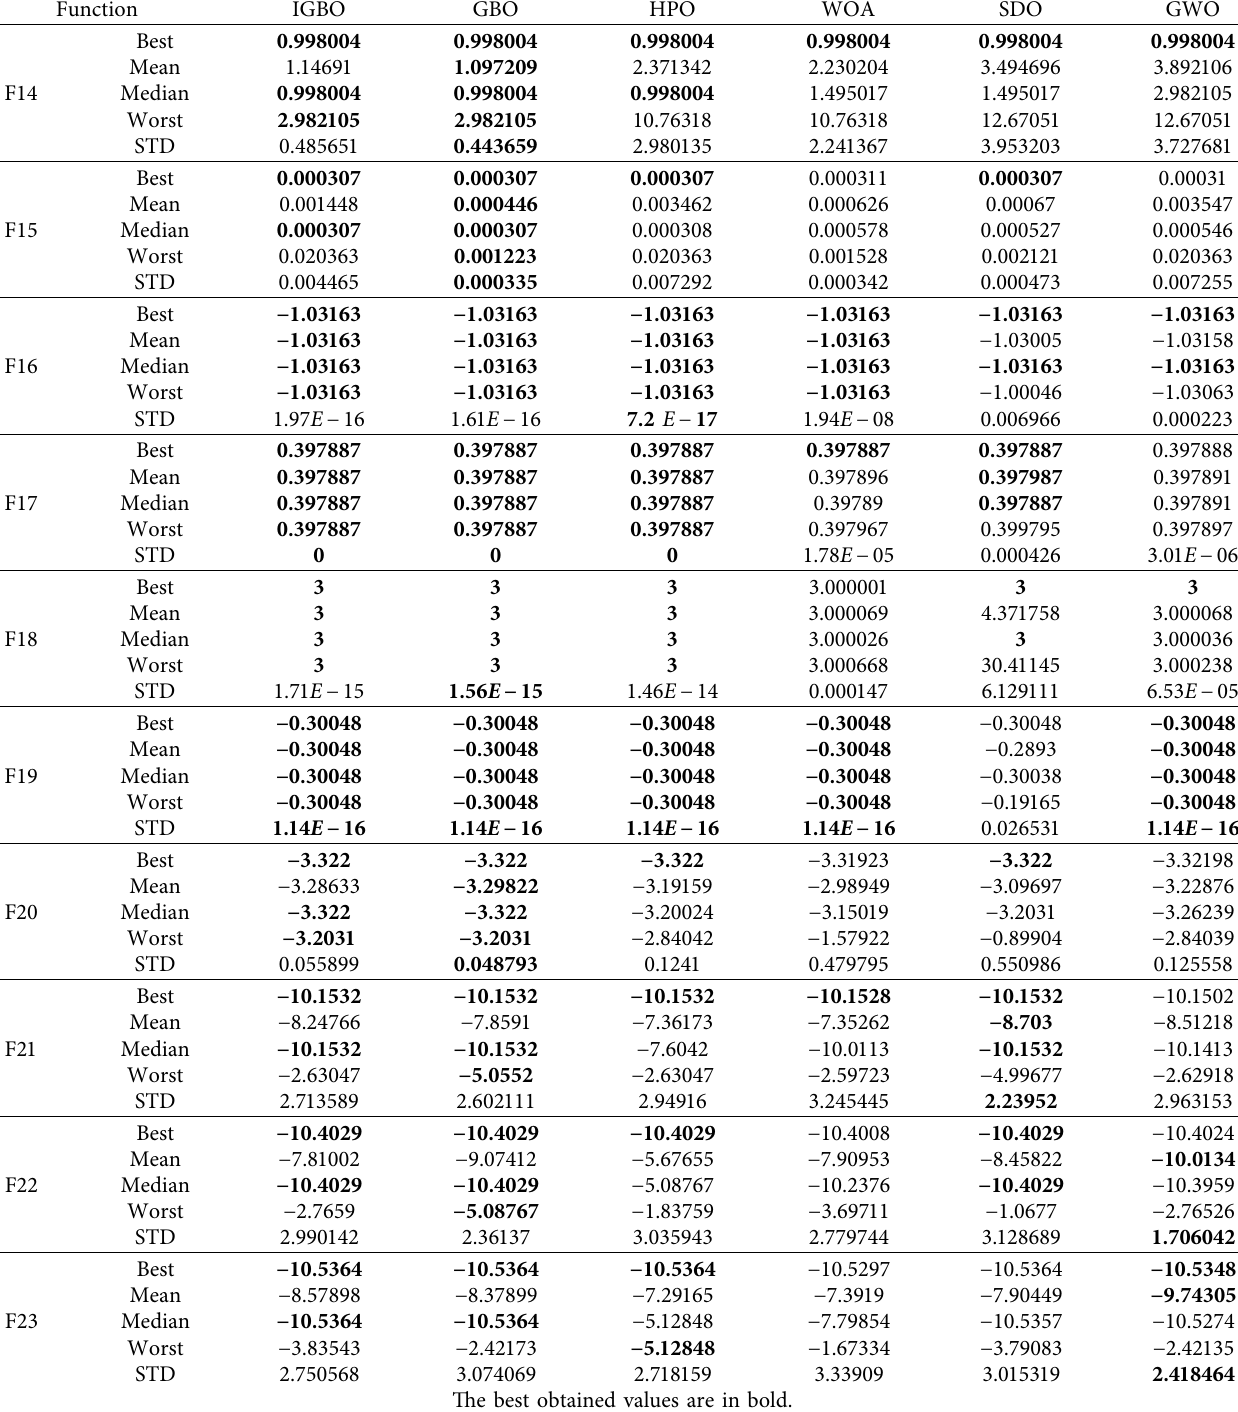
Table 3: Results of composite benchmark